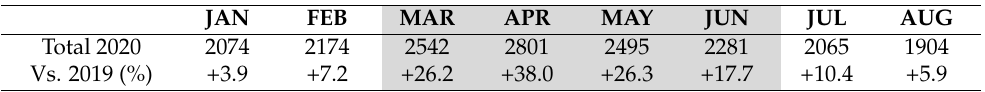
Table 2. Energy values estimated from food and beverages purchased in Spanish households in 2020 (kcal/person/day), and relative change with respect to 2019 (%).